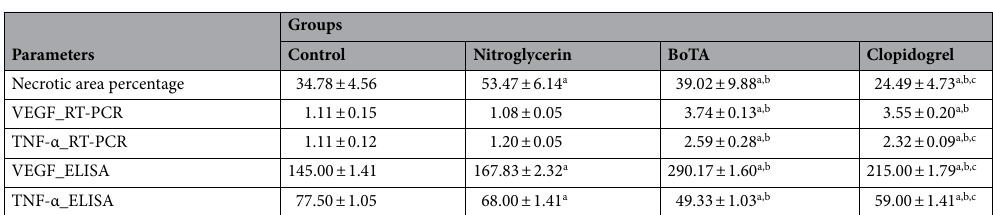
Table 1. Different parameters of induced flap ischemia subgroups. Values are mean ± SD. a P < 0.05 versus control group, b P < 0.05 versus nitroglycerin group and c P < 0.05 versus BoTA group. Statistical analysis was performed by one way ANOVA followed by Tukey’s post-hoc test. BoTA botulinum toxin-A, TNF-α tumour necrosis factor-α, VEGF vascular endothelial growth